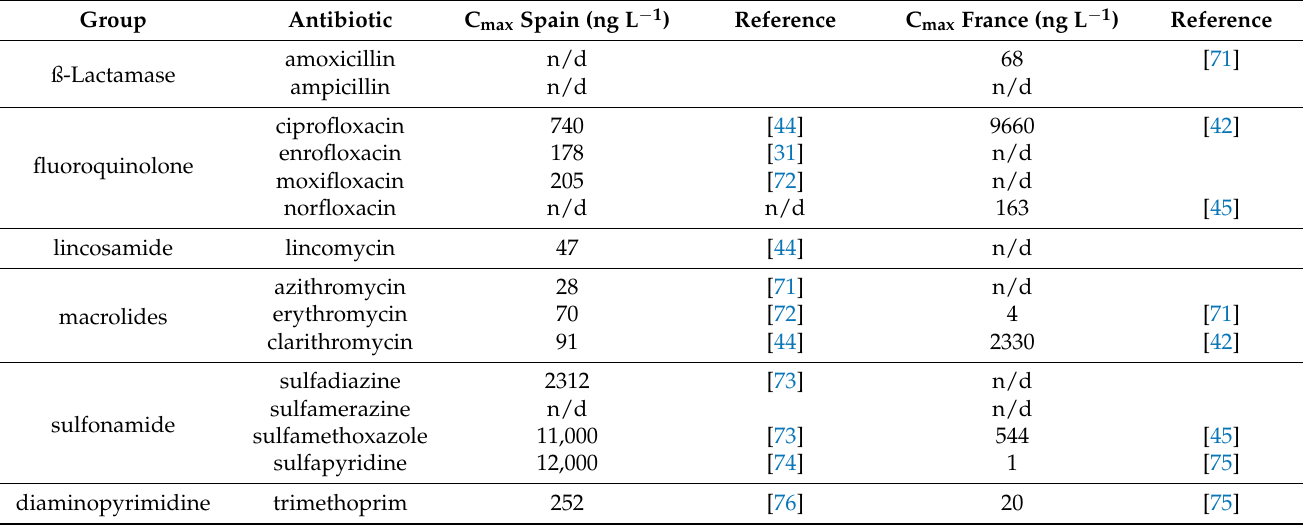
Table A4. Antibiotic maximum concentrations in Spain and